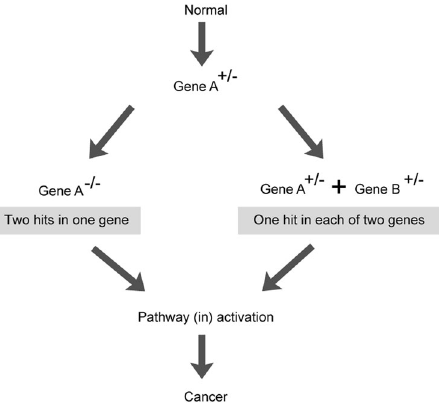
Fig. 5 Alternative evolutionary paths to cancer. Once a driver gene is mutated, either a second hit in the same gene or an alteration in a different gene in the same biological pathway can be alternative evolutionary paths to cancer. That is, for some pathways, two hits may be required to (in) activate it but these hits can either be in one gene or in two different genes. The ordering of events may differ from that illustrated